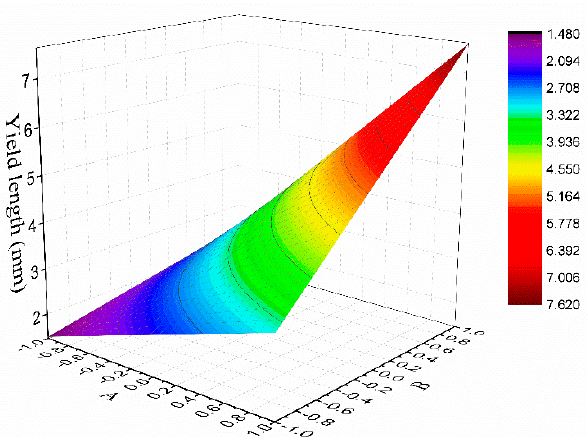
Figure 12. The response surface model for yield length.